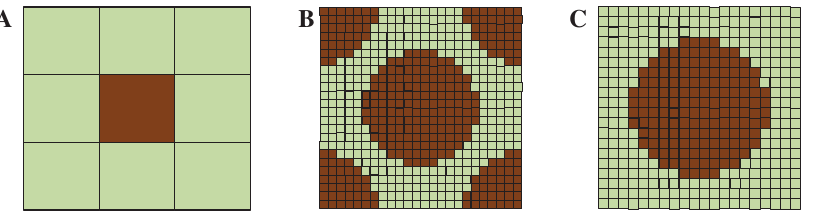
Figure 2 Microstructure of the composites: (A) square fiber with edge packing, (B) circular fiber with diagonal packing and (C) circular fiber with edge packing.